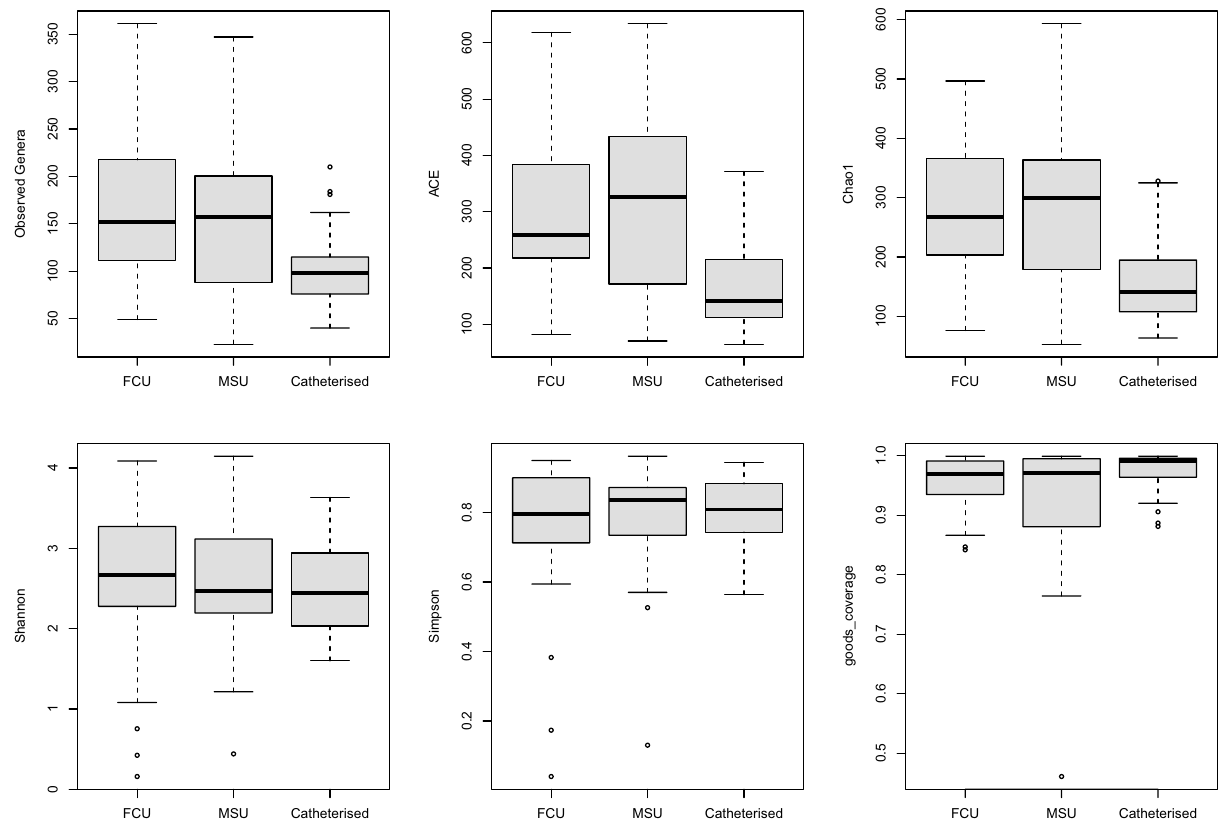
Figure 2. Boxplots comparing alpha-diversity measures and Good´s coverage for first-catch (FCU), mid- stream (MSU) and catheterised urine. See also Table 2. Thick line, median; box limits, upper and lower quartiles; whiskers, 1.5 × interquartile range; points,